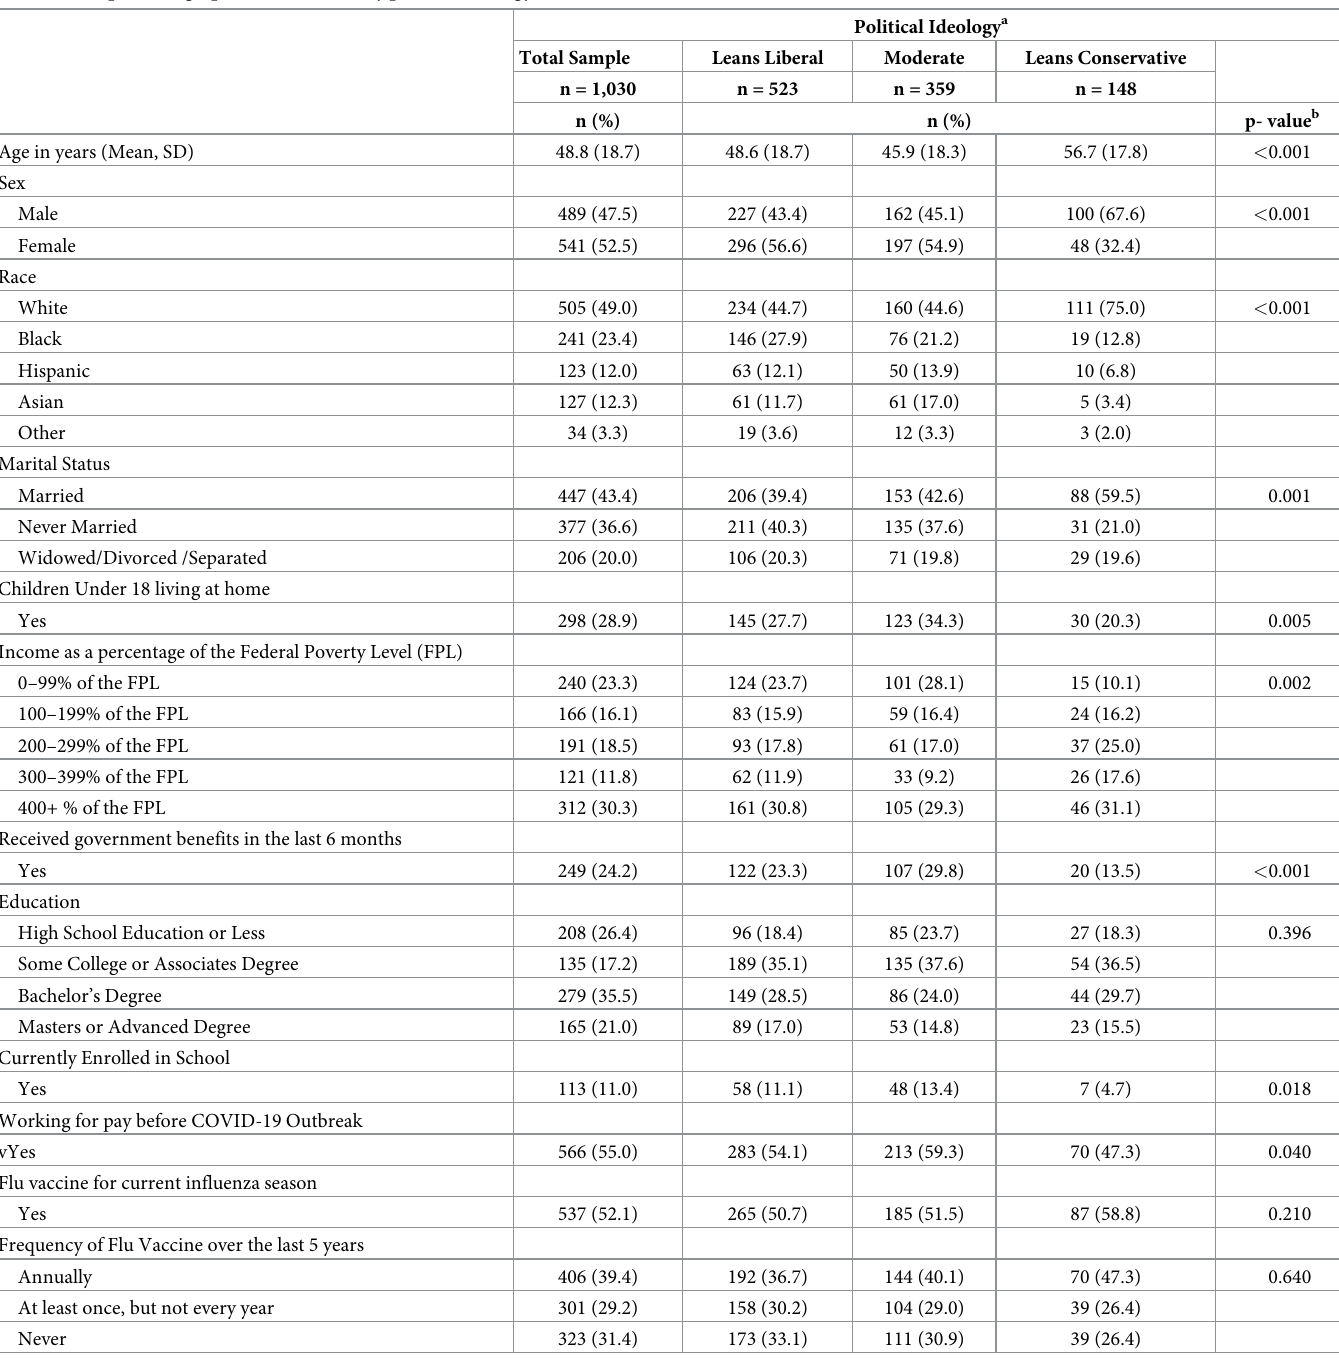
Table 1. Sample demographics: Overall and by political